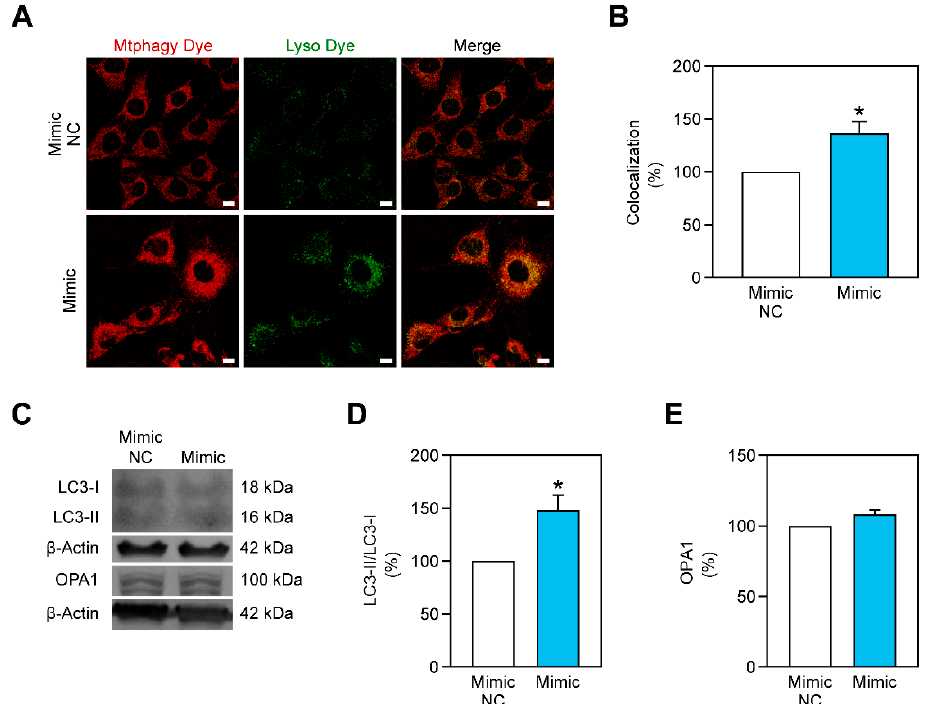
Figure 4 . miR-378a-3p increases mitophagy in C2C12 myoblasts exposed to 3 days of glucose 25 mM. ( A , B ) Mtphagy dye (in red) and Lyso dye (in green) signals as well as the colocalization between them are increased when cells are transfected with miR-378a-3p mimic. Scale bar, 15 μ m. ( C ) Representative images of Western Blot showing that the autophagy-related LC3-II/LC3-I ratio is increased for cells transfected with miR-378a-3p mimic, while mitochondrial fusion-related protein OPA1 was not altered. ( D , E ) Quantification of the LC3-II/LC3-I ratio and OPA1 protein content, respectively. All data is given as mean ± S.E.M. ( n = 3). * p < 0.04 versus Mimic NC.